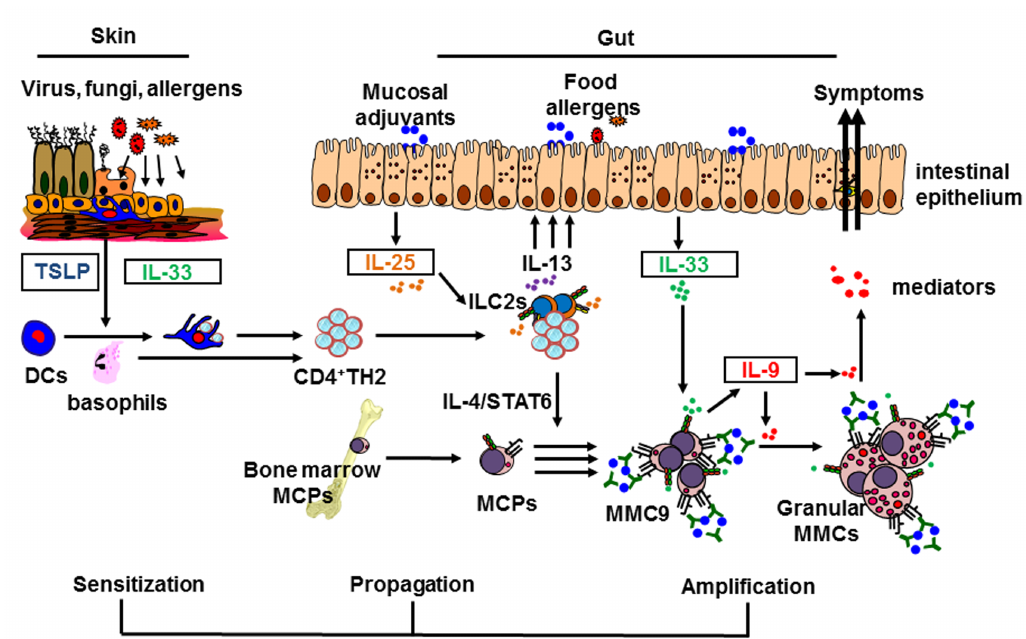
Figure 1. Schematic overview of the stepwise mechanisms involved in the development of immunoglobulin E (IgE)-mediated food allergy. In the allergic sensitization phase, environmental or mechanical triggers (or both) may induce skin keratinocytes to produce thymic stromal lymphopoietin (TSLP), which recruits and activates dendritic cells (DCs) or basophils. Injured epithelial cells may also release interleukin-33 (IL-33) to activate ST2-expressing skin DCs. TSLP-activated DCs migrate to draining lymph nodes to induce naïve CD4 + T cells to differentiate into CD4 + TH2 cells and maintain CD4 + TH2 effector/memory pools. In the allergy propagation phase, these CD4 + TH2 cells migrate to the intestine and interact with resident type-2 innate lymphoid cells (ILC2s) to produce large amounts of IL-13 in response to intestinal IL-25 stimulation. In the amplification-of-mastocytosis phase, IL-4 signals provided by CD4 + TH2 cells induce emigrated mast cell progenitors (MCPs) to become multi-functional IL-9-producing mucosal mast cells (MMC9s), which then expand greatly after ingested antigens cross-link with MMC9 surface IgE/Fc ε R complex. The inflammatory cytokine IL-33 enhances IL-9 production by MMC9s, resulting in MMC9 maturation and the amplification of intestinal mastocytosis in an autocrine loop. Thus, MMC9 induction may serve as a key cellular checkpoint to amplify and propagate allergic inflammation, resulting in the development of IgE-mediated food allergy. MMC, mucosal mast cell; STAT6, signal transducer and activator of transcription 6; TH2, T helper type 2